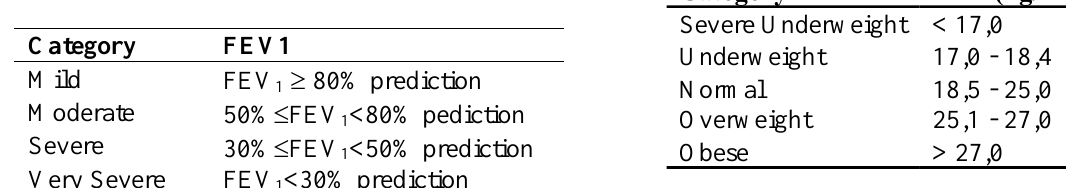
Table 9. Classifications of Body Mass Index